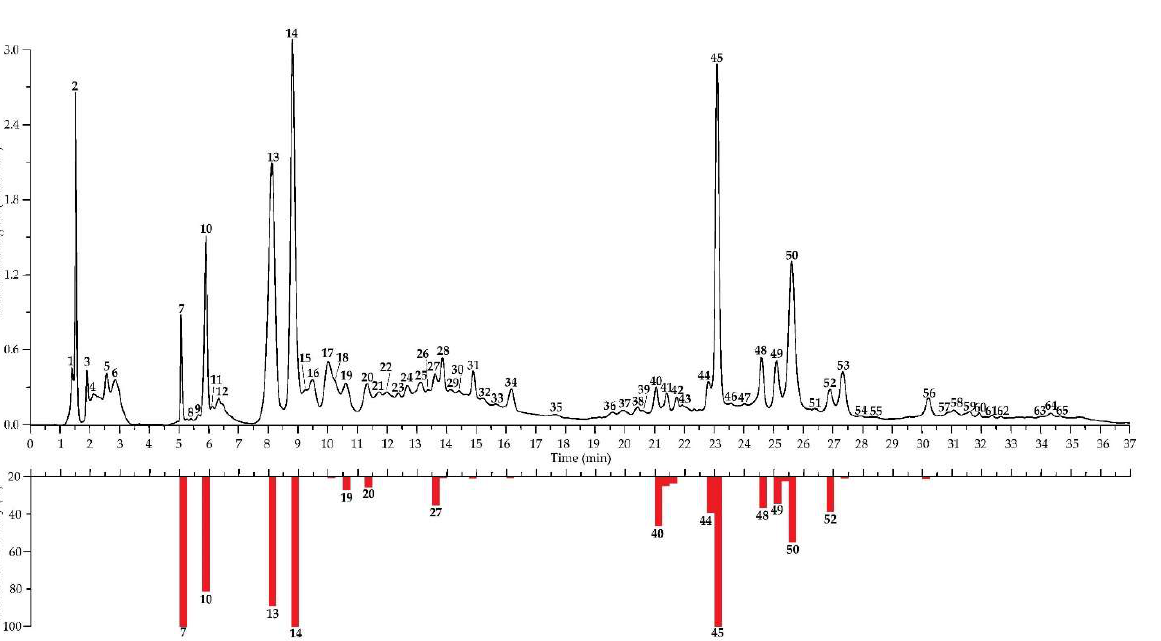
Figure 3. Sensory profiles of F. orientalis fruits, according to estimates by 60 participants. The pref- erence scale ranged from 0 (greatest imaginary dislike) to 10 (greatest imaginary like). Fruits of F.